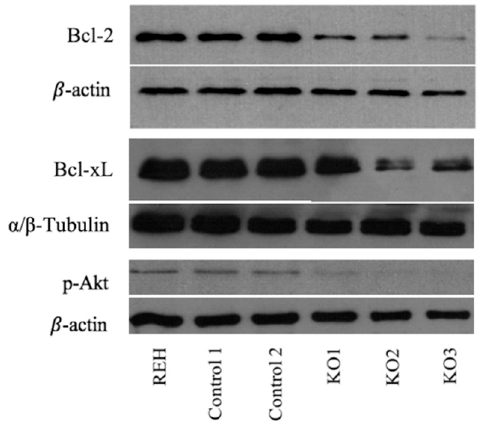
Figure 4. Western blot analysis of E / R targets expression. Lower phospho-Akt (60 kDa), BCL-XL (30 kDa) and BCL-2 (28 kDa) expression levels were observed in all E / R KO clones compared with parental cell line (REH) and control clones. This experiment had three replicates.